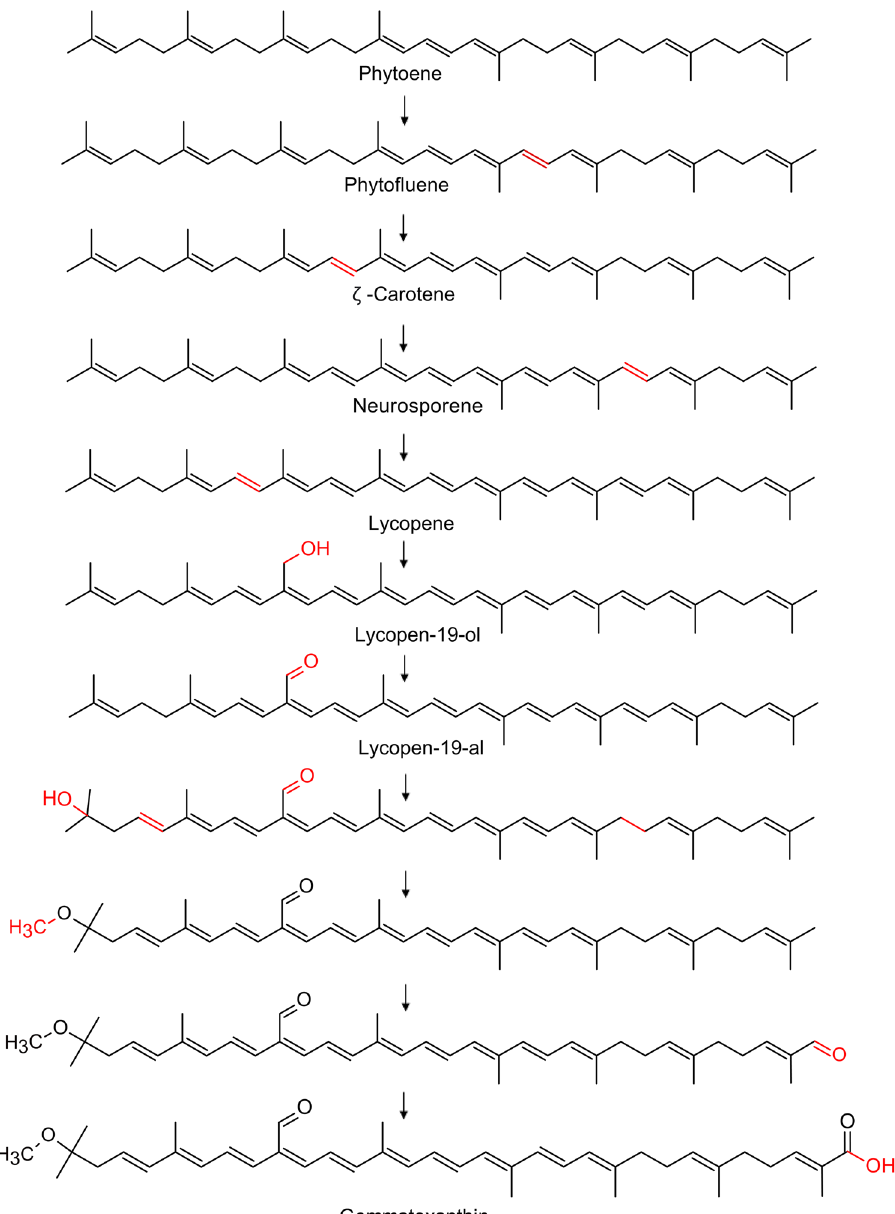
Figure 5. Tentative biosynthetic pathway of gemmatoxanthin. The biosynthesis of the gemmatoxanthin pathway begins from phytoene and lycopene 9 . Lycopene undergoes modification by the hydroxylase/oxidase activity of enzymes (genes are not yet known) to form lycopen-19-al which was tentatively predicted in Lamprocystis roseopersicina belonging to the Chromatiaceae family 50,51 . The cruF gene and crtF gene are probably responsible for the addition of terminal methoxy group in the pathway 8 . We hypothesize that the 1 ′ carbon of methyl group undergoes modification by the hydroxylase/oxidase enzyme encoded by cruH gene yielding carboxylic acid, which is already known in synechoxanthin pathway 29,54 . Two unidentified genes similar to cruH gene was found in the genome of the G. phototrophica AP64 using tblastn showing 36.607% similarity (GEMMAAP_15370) and 23.034% identity